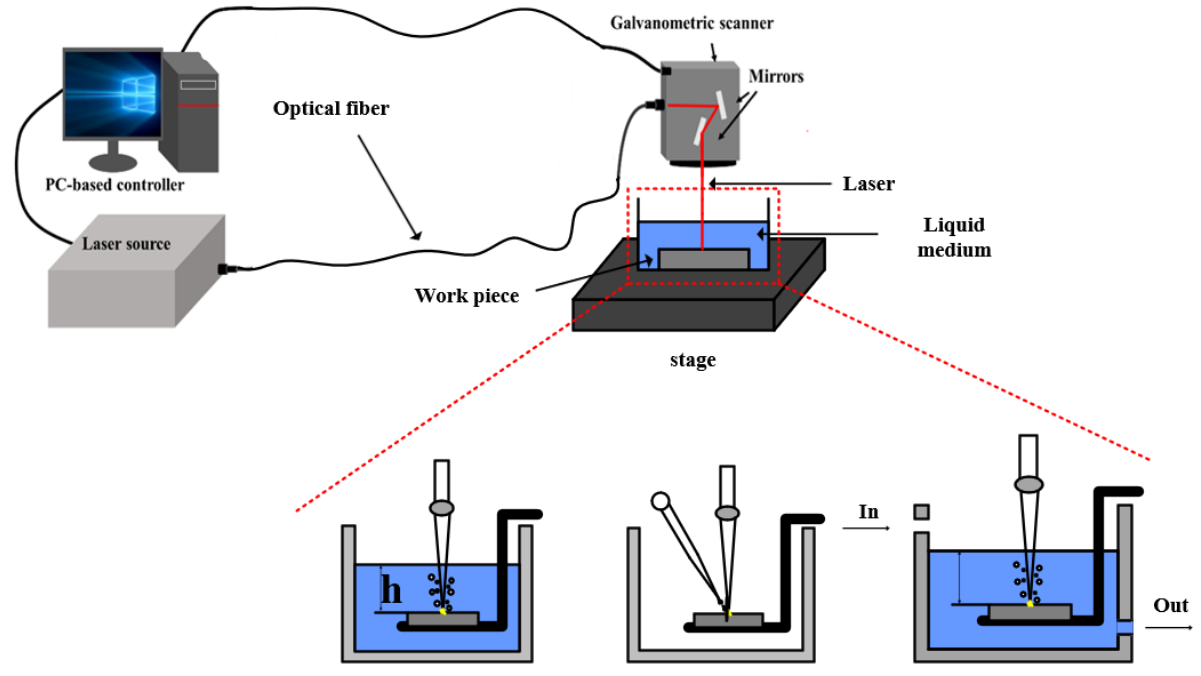
Figure 5. Experimental scheme of underwater laser ablation.